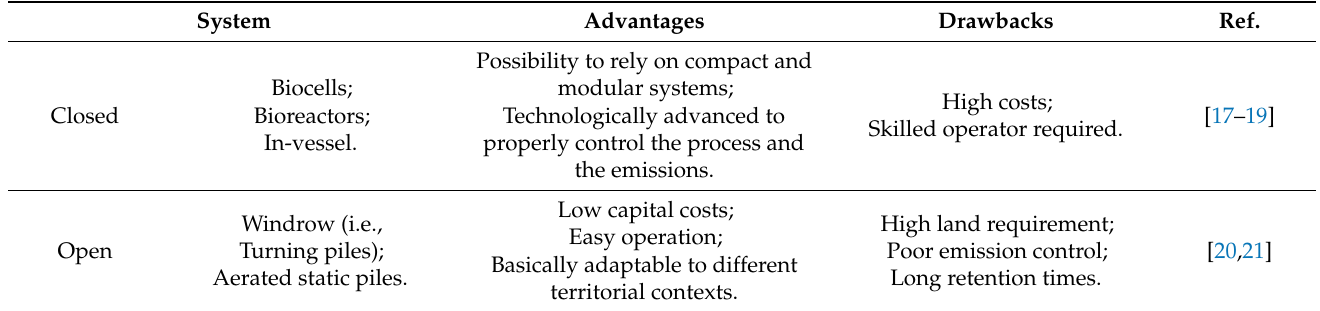
Table 1. Composting systems: main advantages and